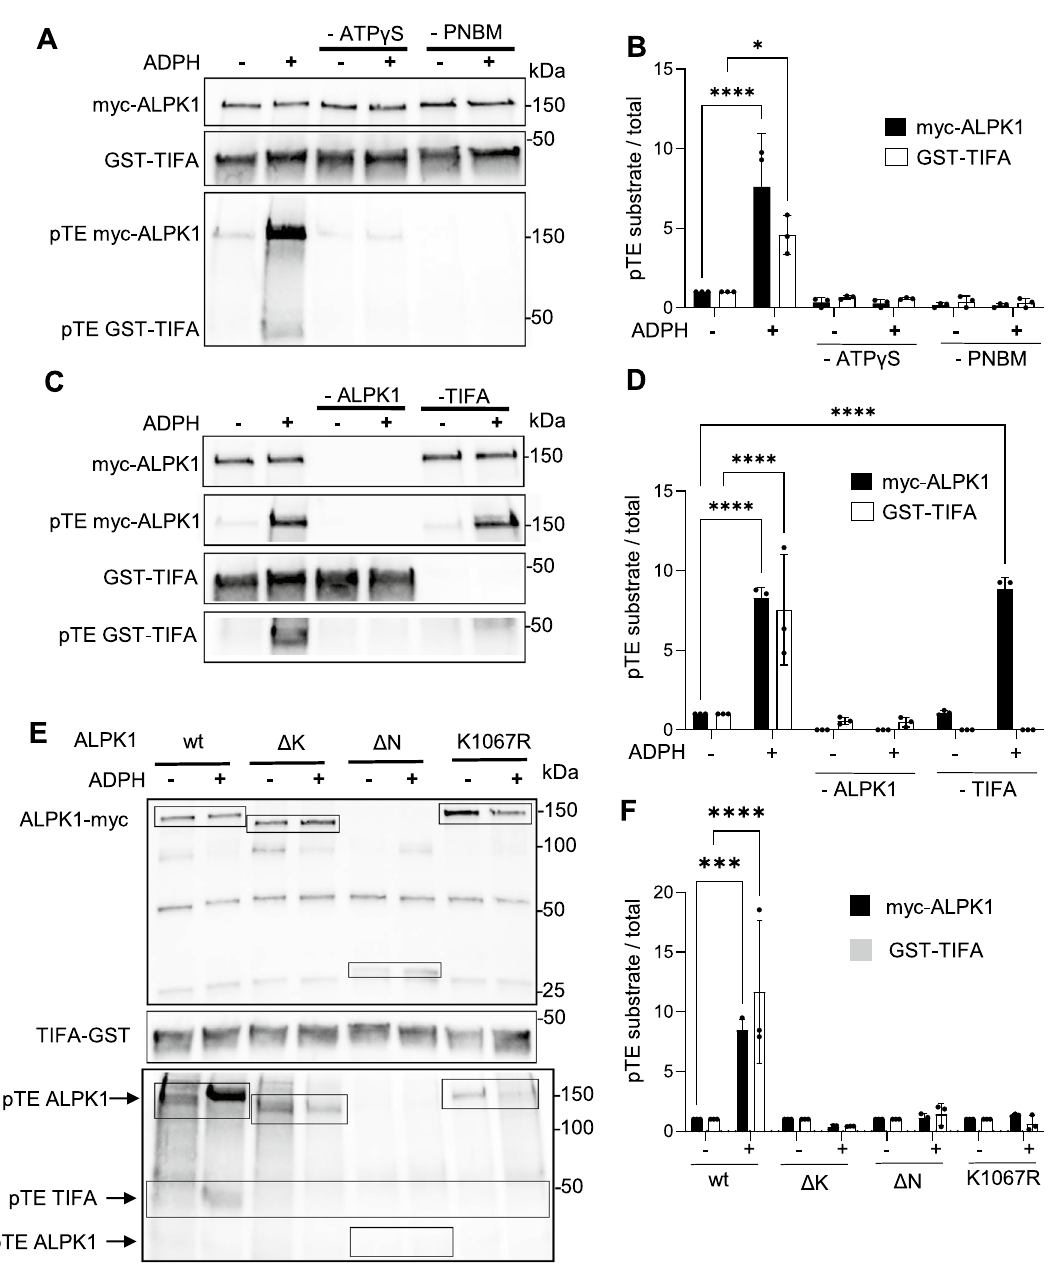
Figure 2. In vitro kinase assay based on protein thiophosphorylation reveals the phosphorylation of ALPK1 in response to ADPH sensing. ( A ) TIFA and ALPK1 are thiophosphorylated in response to ADPH sensing. HEK293 cells, transfected with a myc-hALPK1 cDNA construct, were treated or not with ADPH for 30 min. myc-ALPK1 was immunoprecipitated and incubated with GST- TIFA ± ATPγS and ± PNBM. Anti-myc, anti-GST and anti-pTE antibodies were used in western blot to detect myc-ALPK1, GST-TIFA and thiophosphorylated proteins, respectively. ( B ) Quantification of protein thiophosphorylation as shown in ( A ). For GST-TIFA or myc-ALPK1, protein thiophosphorylation was quantified by measuring the ratio between corresponding pTE signal and total GST-TIFA or myc-hALPK1, respectively. ( C ) Protein thiophosphorylation signals are dependent on ALPK1 and TIFA. HEK293 cells were transfected or not with a myc-hALPK1 cDNA construct and treated or not with ADPH. myc-ALPK1 was immunoprecipitated and incubated or not with GST-TIFA in the presence of ATPγS and PNBM. Anti-myc, anti-GST and anti-pTE antibodies were used in western blot to detect myc-ALPK1, GST-TIFA and thiophosphorylated proteins, respectively. ( D ) Quantification of protein thiophosphorylation as shown in ( C ). For GST-TIFA or myc-ALPK1, protein thiophosphorylation was quantified by measuring the ratio between corresponding pTE signal and total GST-TIFA or anti-myc, respectively. ( E ) TIFA and ALPK1 thiophosphorylation is dependent on the kinase and N-terminal domains of ALPK1 and requires intact kinase activity. HEK293 cells were transfected with wt, ΔK, ΔN and K1067R myc-tagged ALPK1 cDNA constructs and were treated or not with ADPH. myc-ALPK1, GST-TIFA and thiophosphorylated proteins were detected as in ( A ). ( F ) Quantification of protein thiophosphorylation as shown in ( E ). GST-TIFA and myc-ALPK1 thiophosphorylation was quantified as in ( B ). All data correspond to the mean ± SD of 3 independent experiments. Statistical significance against the untreated wt condition was assessed using two ‐ way ANOVA ( B , D , F ) followed by Tukey’s multiple comparisons test * P < 0.05, *** P < 0.001 **** P <